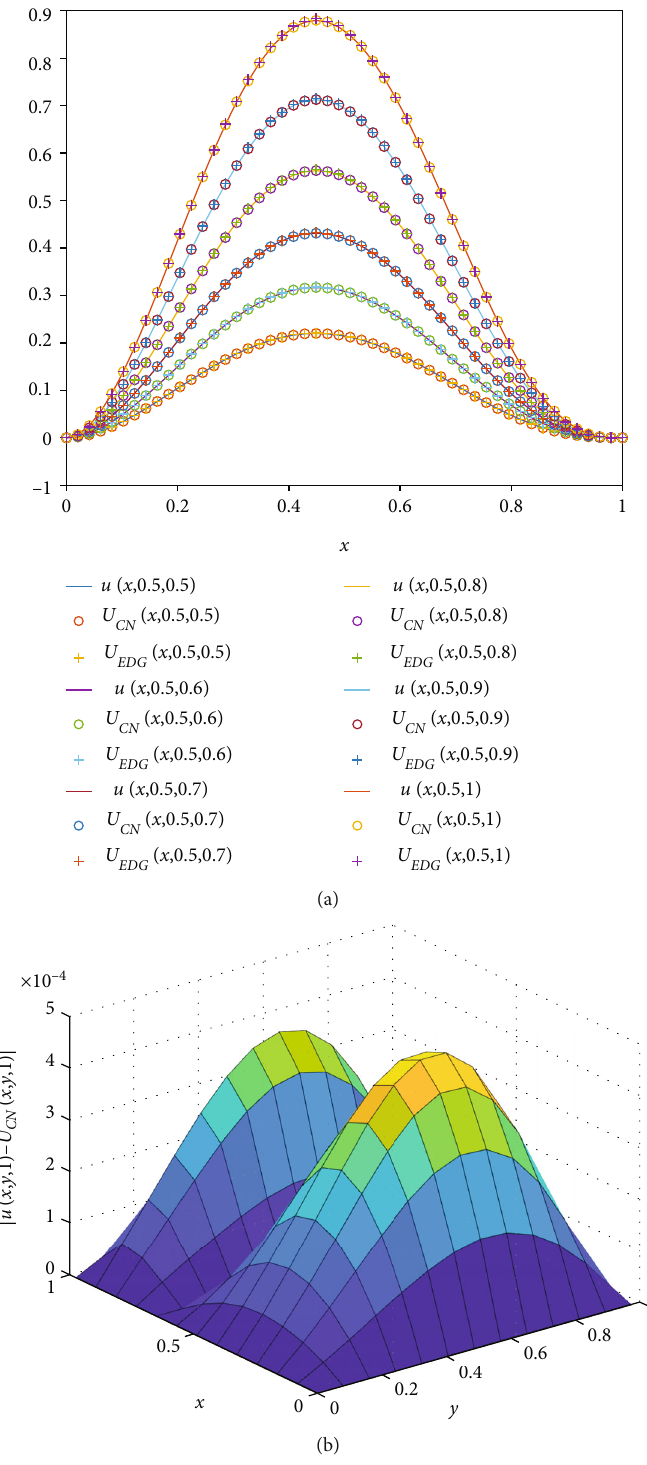
Figure 5: The exact, Crank – Nicolson and EDG solutions in di ff erent values of t and y = 0 : 5 (a) and the absolute error of Crank – Nicolson method at T = 1 (b) of Example 15 for Δ t = 0 : 01 , Re = 20 , N = 49 , and α = 0 : 5